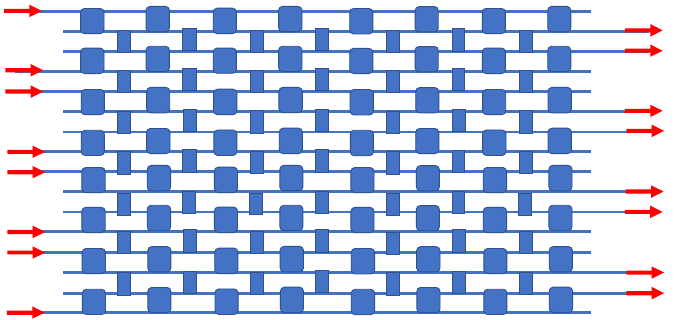
Figure 7. Block diagram of the monochromatic 8 × 8 PILOSS-topology matrix switch. Each narrow blue rectangle represents a passive IDC crossover, with the squares indicating EO switches. This diagram is based upon the diagram in Figure 6c of [50].